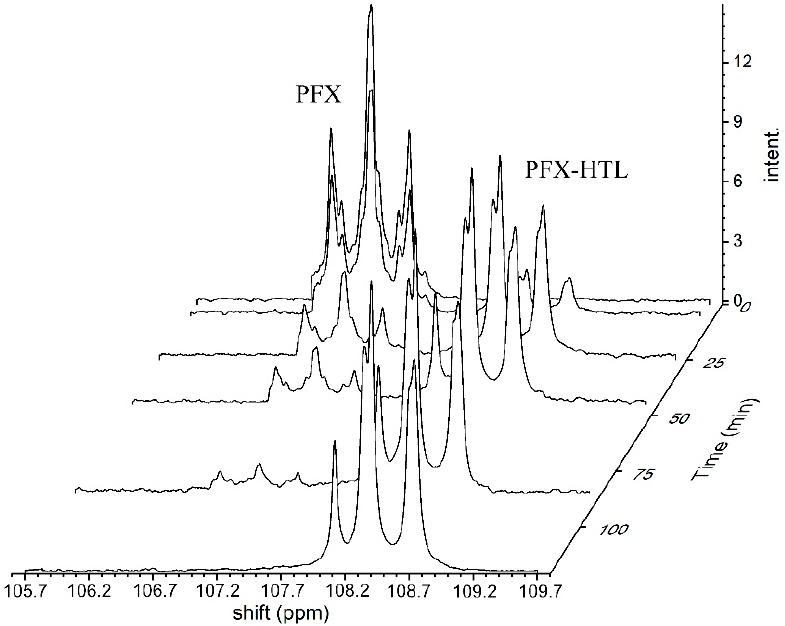
Figure 6. Typical 19 F NMR spectra of the PFX and HTL reaction in DMSO in the presence of triethyl- amine in the CF 3 groups’ shift diapason. The PFX:HTL:NEt3 ratio is 1:2.5:3.3.